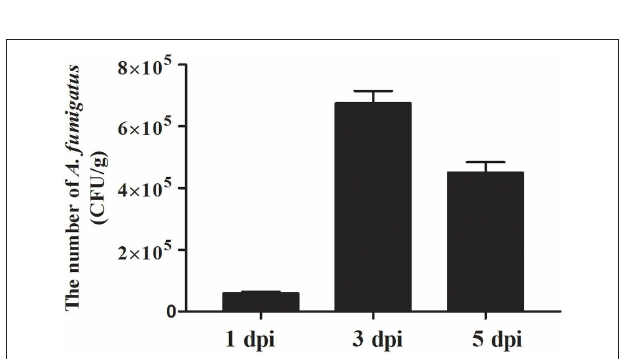
FIGURE 3 | Pathogen load after infection with Aspergillus fumigatus . Right lungs were sampled in infected and control chickens (3 chickens per group). Aspergillus fumigatus load was measured using the plate counting method and expressed as means CFU per gr of tissue ± SD ( n = 3).